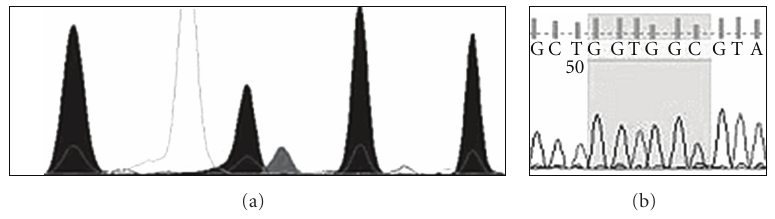
Figure 1: The electropherograms of the SNaPshotanalysis(a)and the DNA sequencing (b) of the same tumor tissue sample. The mutationof codon 12 position 2 guanine to adenine transition is definitely visible in the SNaPshot analysis. In the sequencing analysis, the adenine-peak is hardly distinguishable from the